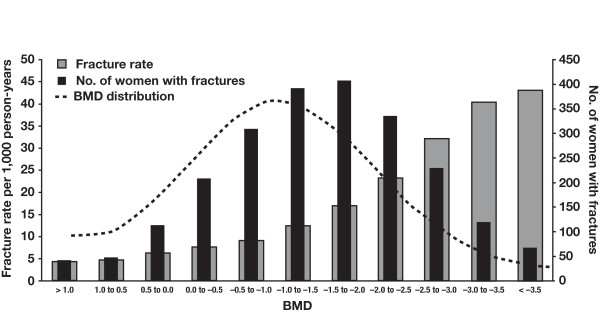
Fracture rate, BMD distribution, and number of fractures based on NORA. Abbreviations: BMD, bone mineral density; NORA, National Osteoporosis Risk Assessment. Reprinted with permission from Siris ES, et al. Arch Intern Med. 2004;164:1108-1112 [47]. Copyright © 2004, American Medical Association. All rights reserved.